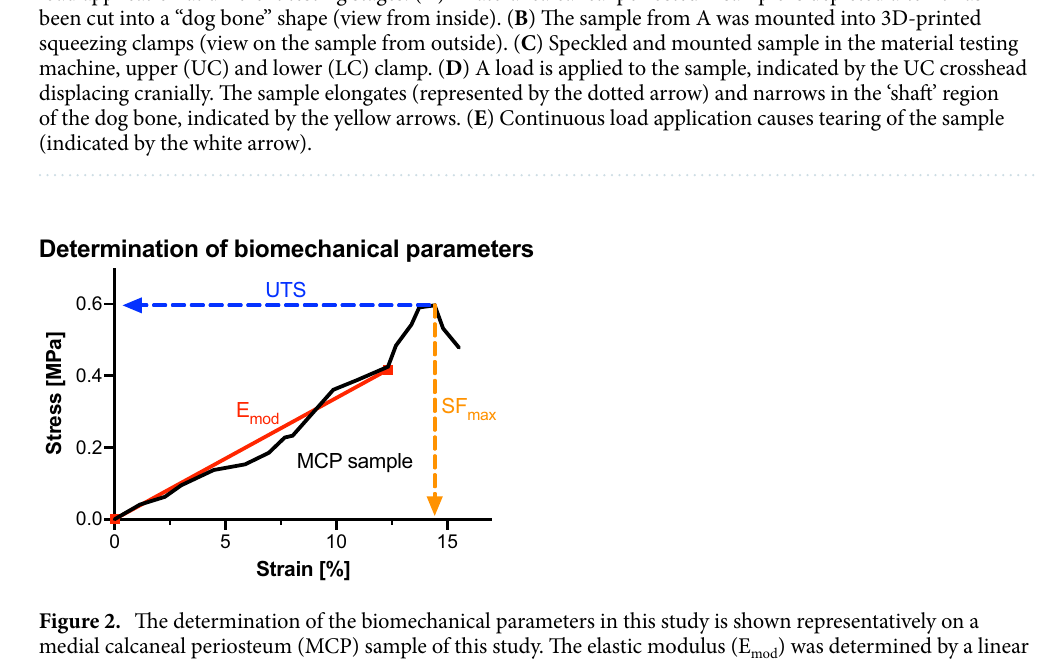
collagen orientation. The displacement rate was 20 mm/min and the sample reading rate was 100 Hz. A single- charge coupled camera with a resolution of 2.8 Megapixels (Q400; Limess, Krefeld, Germany) and the ISTRA 4D software (VRS 4.4.1.354; Dantec Dynamics, Ulm, Germany) were used for strain data evaluation of the mechanical tests. Data processing and statistical analysis. Synchronized force readings by MATLAB R2017b software